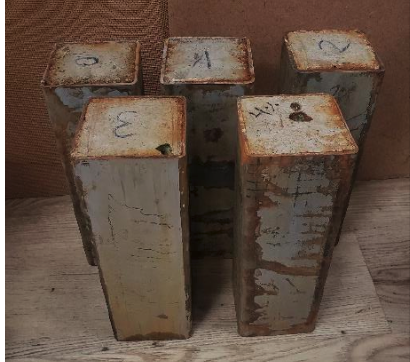
Figure 1. CFST stub columns.